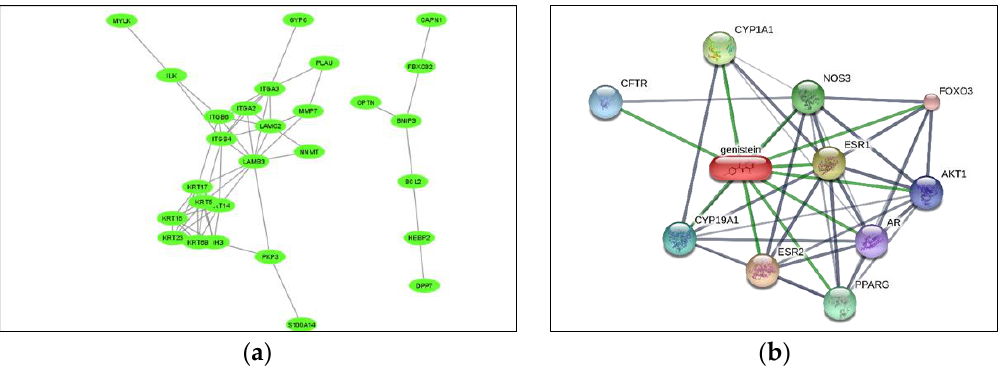
Figure 15. ( a ) Differentially expressed gene network. ( b ) Drug–gene network for genistein. For a ligand-based drug–gene network, the above-mentioned forty-four genes and twelve chemical compounds are selected using ToppGeneFun software [79]. Among them, only the natural product genistein is selected as a drug for the treatment of COVID-19 infection. Genistein is a phytoestrogen and belongs to the category of isoflavones. The gene network with genistein drawn with the STITCH database is shown in Figure 15b